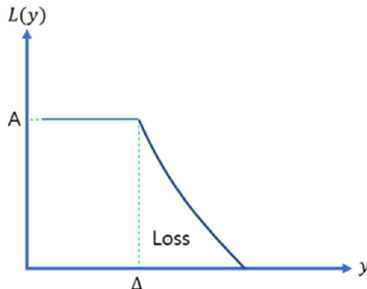
Figure 1. Larger-the-better characteristics.